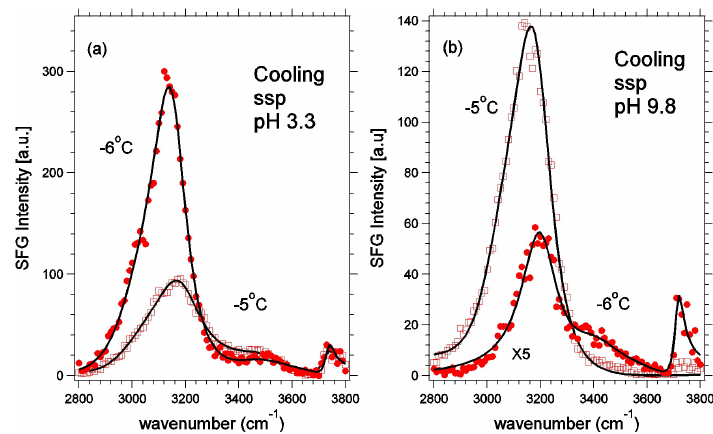
Figure 20. Sum frequency generation (SFG) collected in SSP polarization during cooling for two different pH scales. Water is represented as open squares while ice is shown by filled circles with the spectra showing transitions near the freezing and melt temperatures. Reprinted with permission from Ref. [184]. c (cid:13) 2013 American Chemical